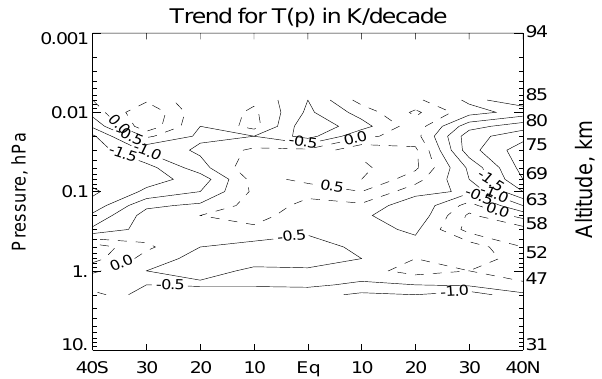
Fig. 16. Contour plot of the diagnosed, linear trend terms (in K/decade) from HALOE. Contour interval is 0.5K/decade, and the zero and positive (warming) trends have dashed